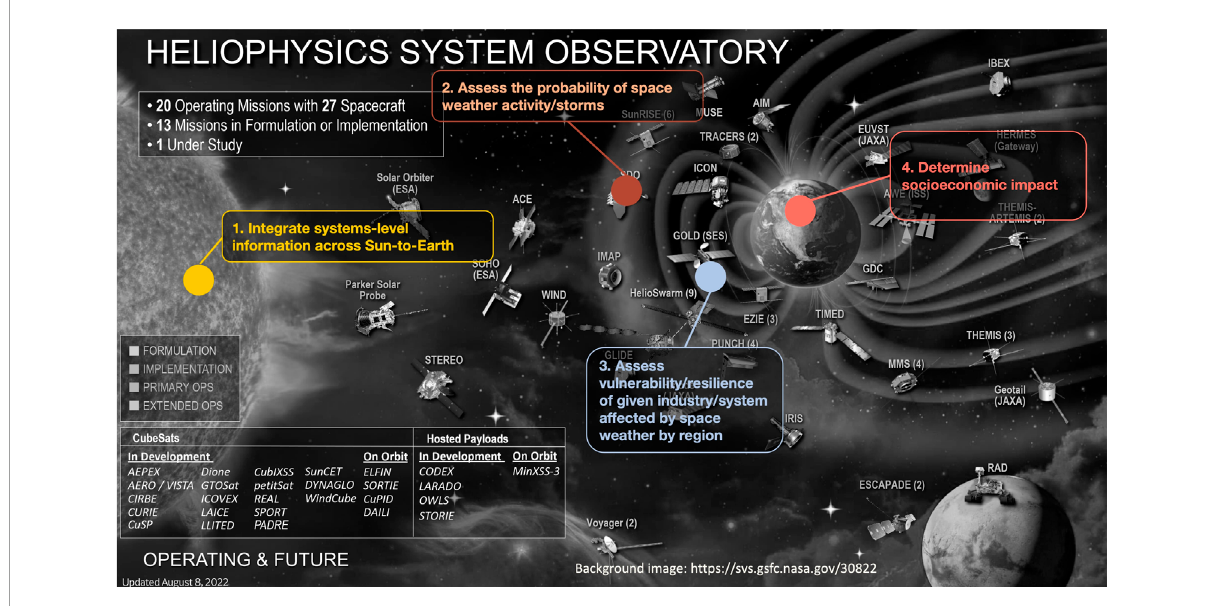
FIGURE 1 Overview of the Space Weather Risk and Resiliency Framework. Adapted from https://svs.gsfc.nasa.gov/30822 (original credit: NASA).